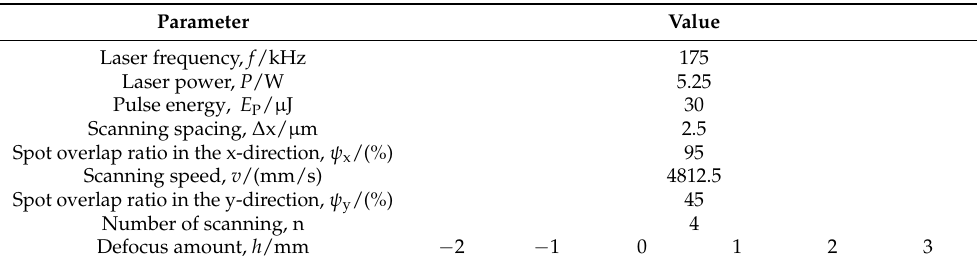
Table 4. Experimental parameters of femtosecond laser polishing of SiC ceramics with variable defocus